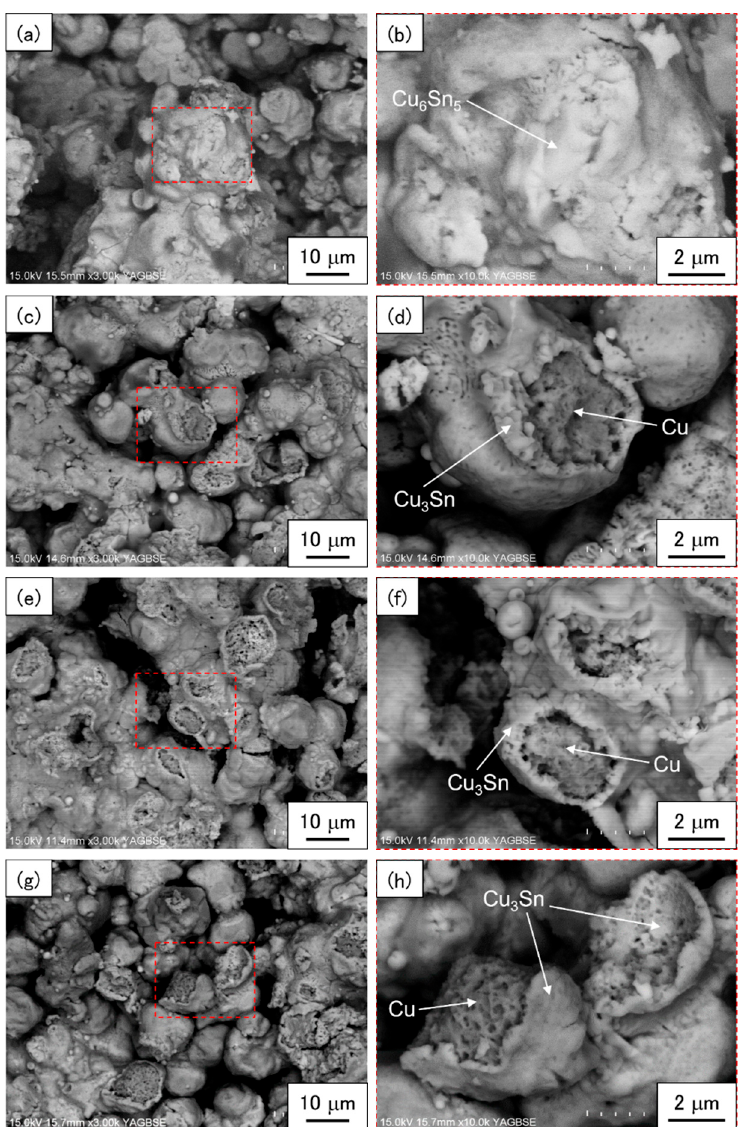
Figure 12. Fracture surfaces of the joints ( a , b ) as-bonded and aged at ( c , d ) 150, ( e , f ) 175, and ( g , h ) 200 °C for 1000 h.